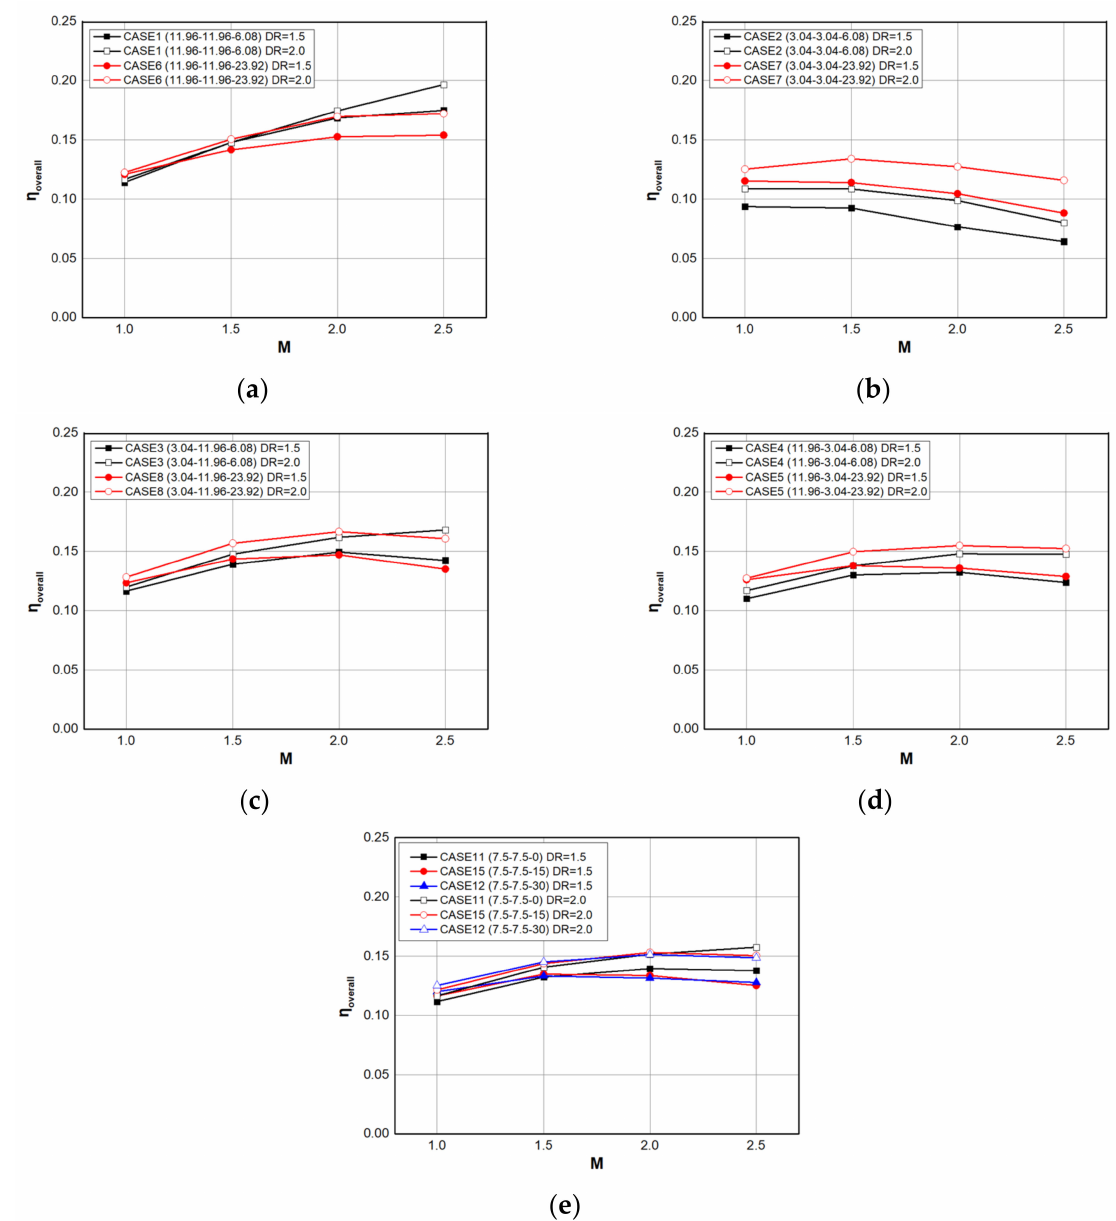
Figure 9. Overall averaged FCE for the effect of compound angle: ( a ) 11.96-11.96- θ cases; ( b ) 3.04- 3.04- θ cases; ( c ) 3.04-11.96- θ cases; ( d ) 11.96-3.04- θ cases; ( e ) 7.5-7.5- θ